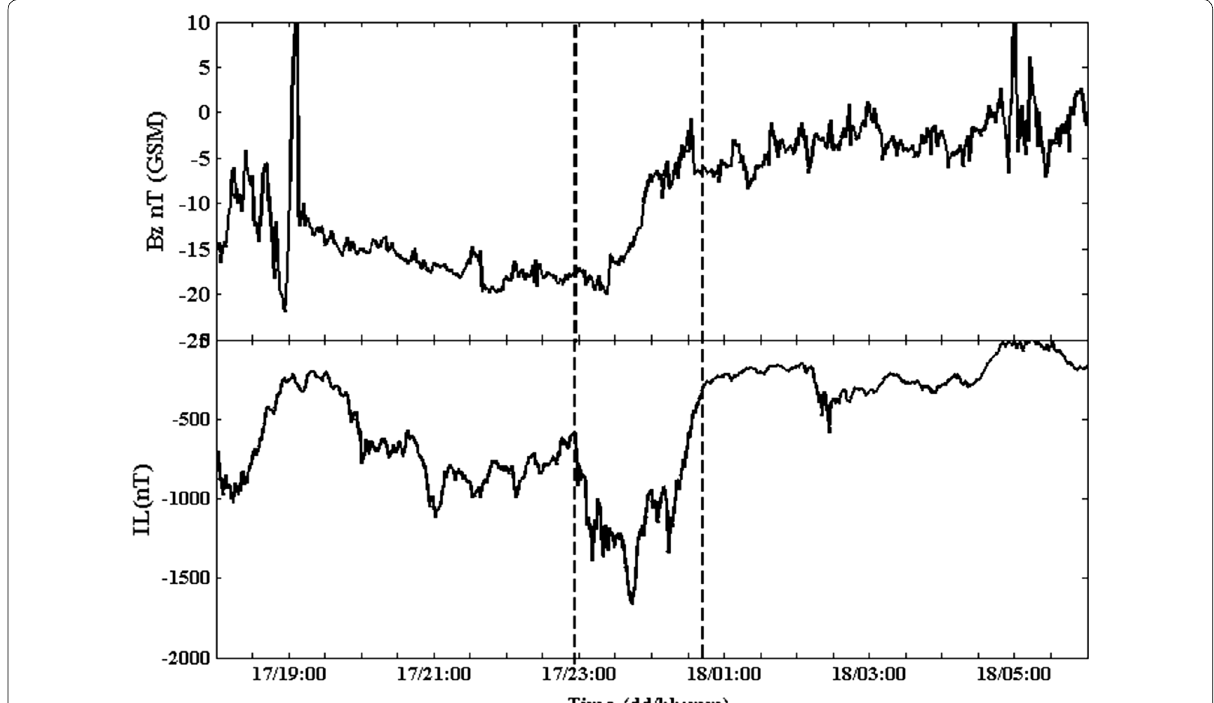
Fig. 6 Top to bottom: IMF B z (in GSM coordinate) from WIND spacecraft and the local electrojet index (IL) derived from the IMAGE magnetometer network, during substorm event 17–18 March 2015. The duration of expansion phase of the substorm is marked with two vertical dashed